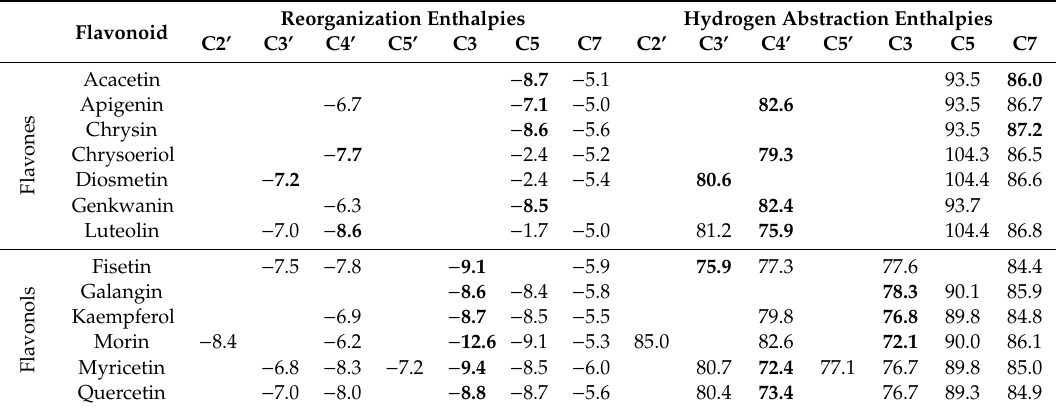
Table 6. Values of reorganization enthalpies and hydrogen abstraction enthalpies [kcal /